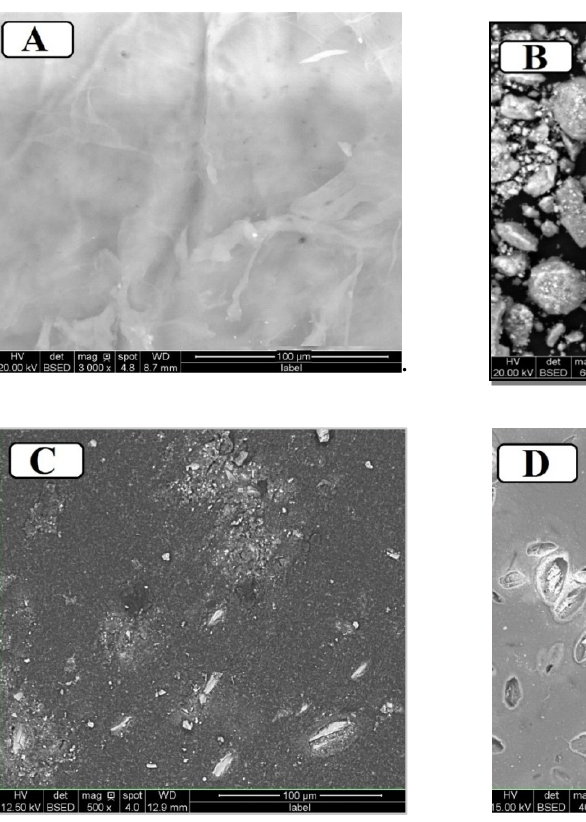
Figure 2. SEM images of CH ( A ), TNP ( B ), Pristine CH-TNP ( C ), Cu(II) saturated CH-TNP ( D ), and N 2 adsorption/desorption isotherm ( E ).